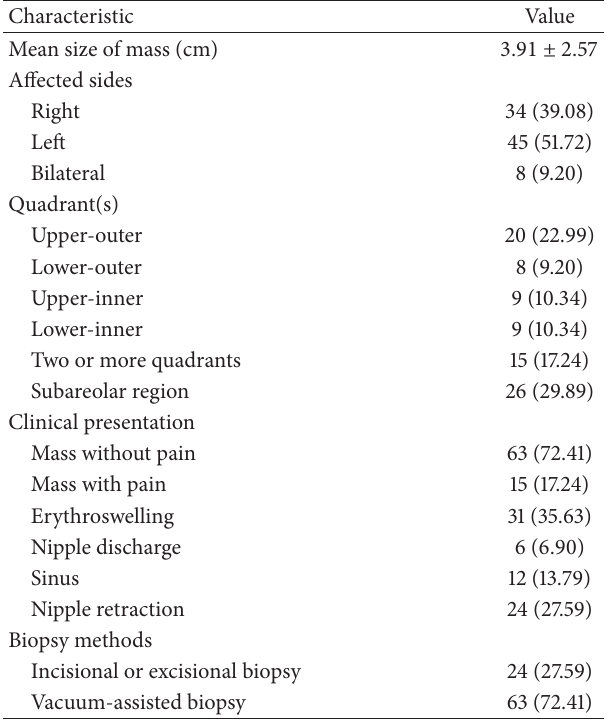
Table 2: Clinical characteristics and presentations of patients with PDM.